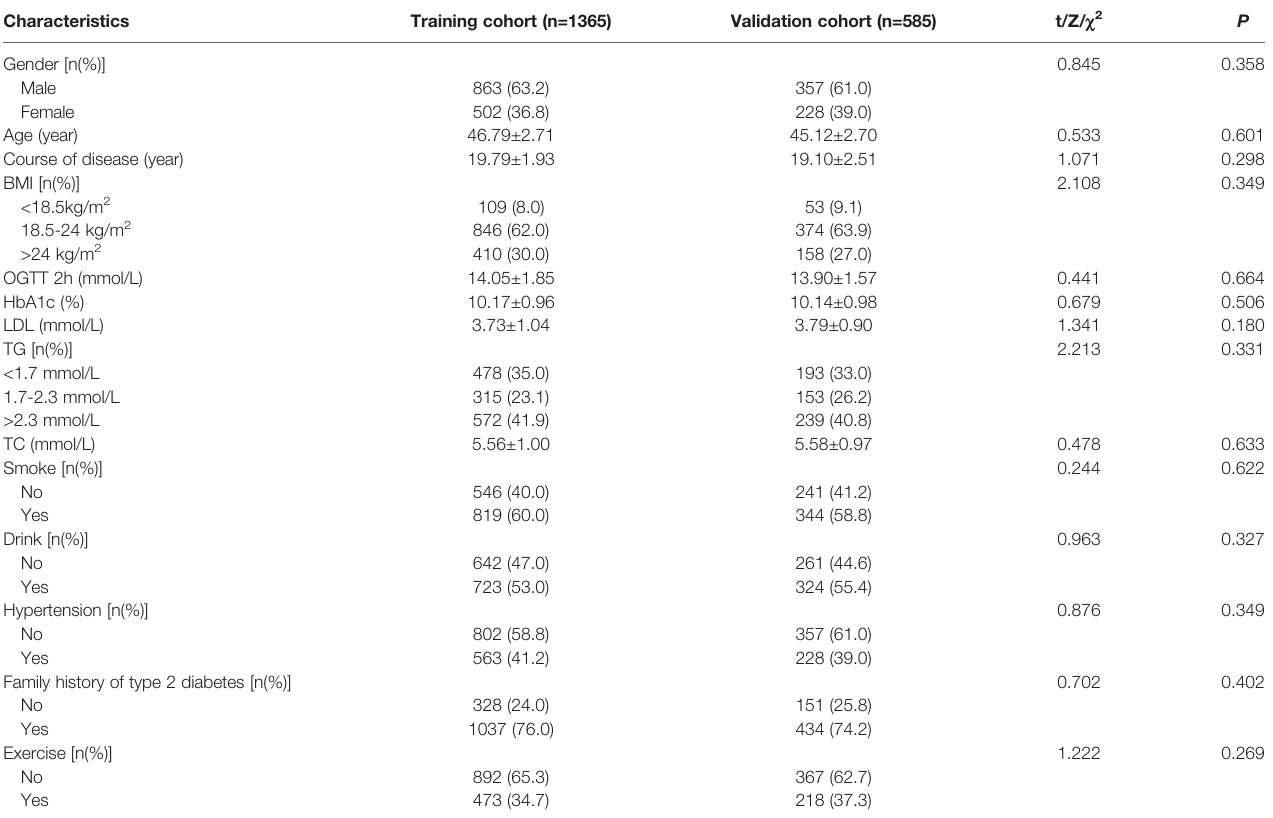
TABLE 1 | Characteristics of the patients in the training cohort and validation cohort.